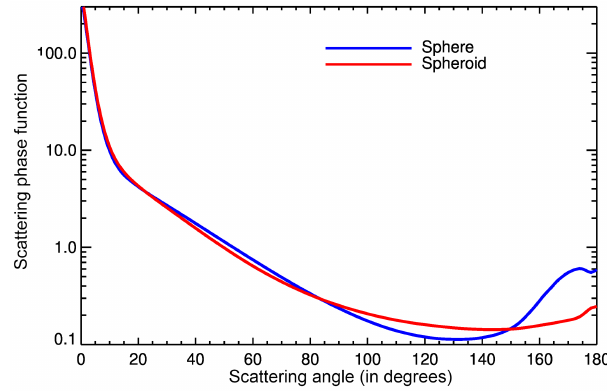
Figure 5. Calculated scattering phase function of spheres (blue) and spheroids (red) at 388nm for SSA = 0.9. Assumed refractive index 1.55 + 0.00405i. See text for additional